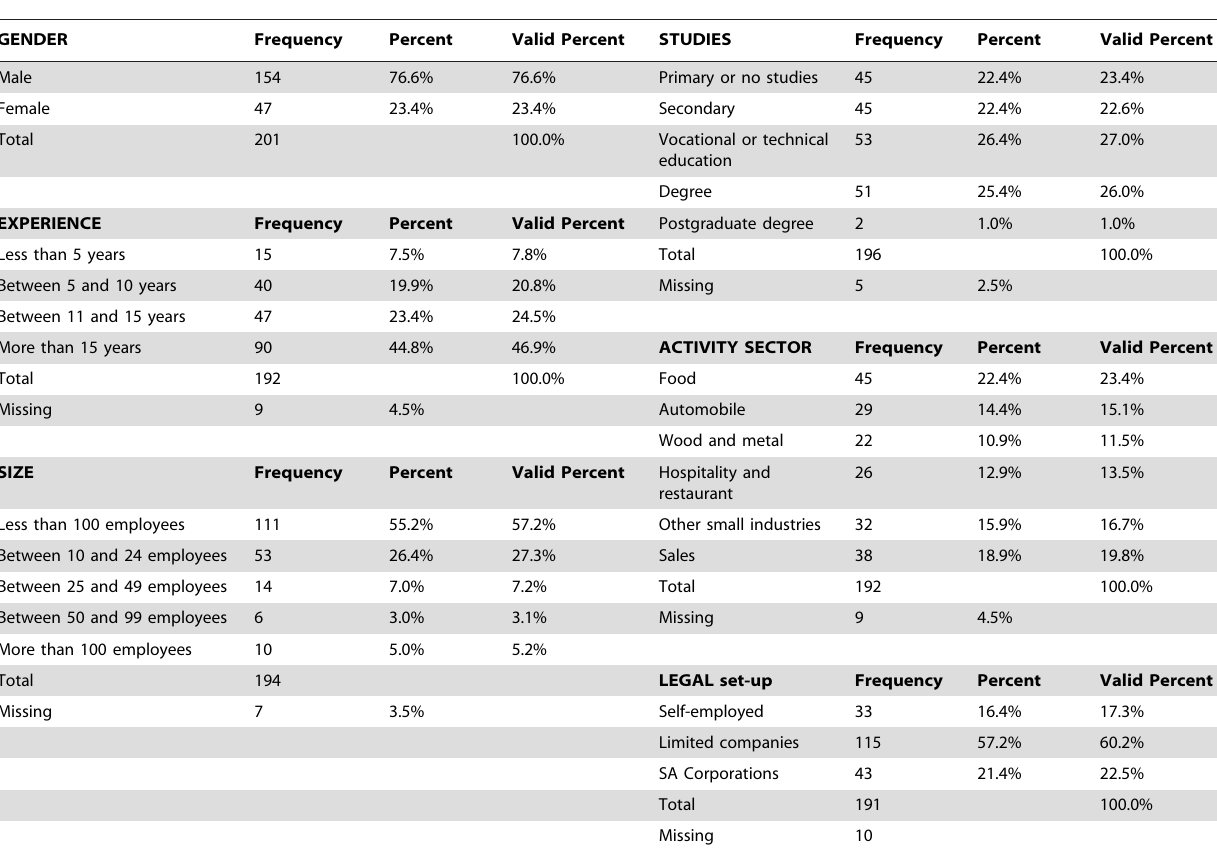
Table 2. Description of the